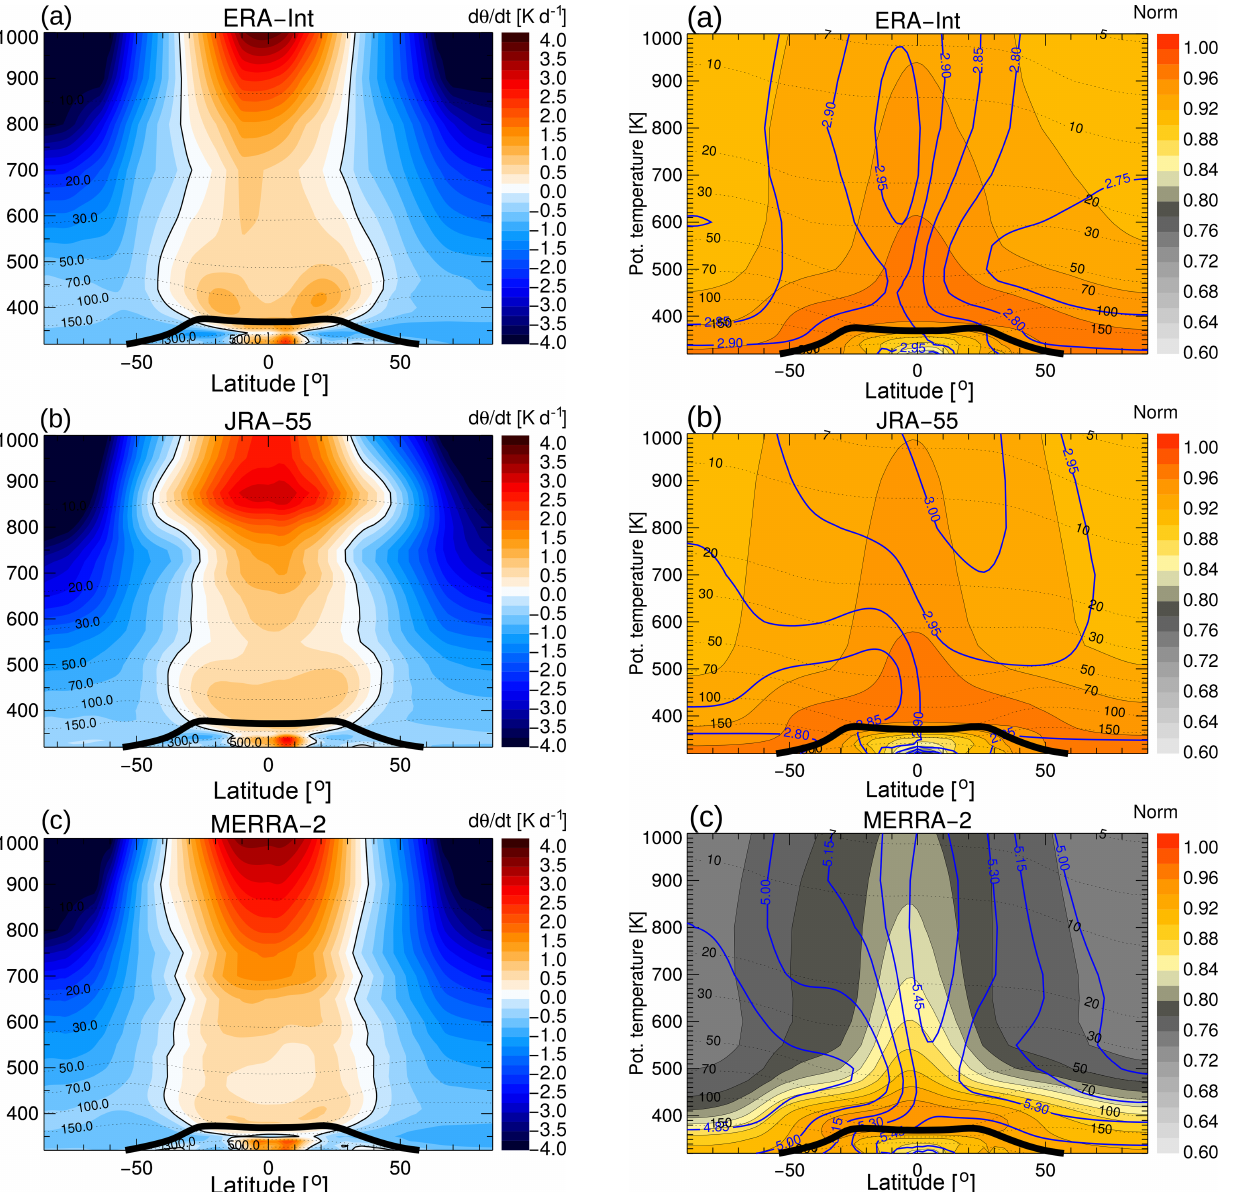
Figure 5. Cross-isentropic vertical velocity d θ/ d t from the total di- abatic heating rate for ERA-Interim (a) , JRA-55 (b) and MERRA- 2 (c) . Climatological annual mean distributions for 1989–2015 are shown. The thin black lines show pressure contours, and the thick black line is the (lapse rate) tropopause.